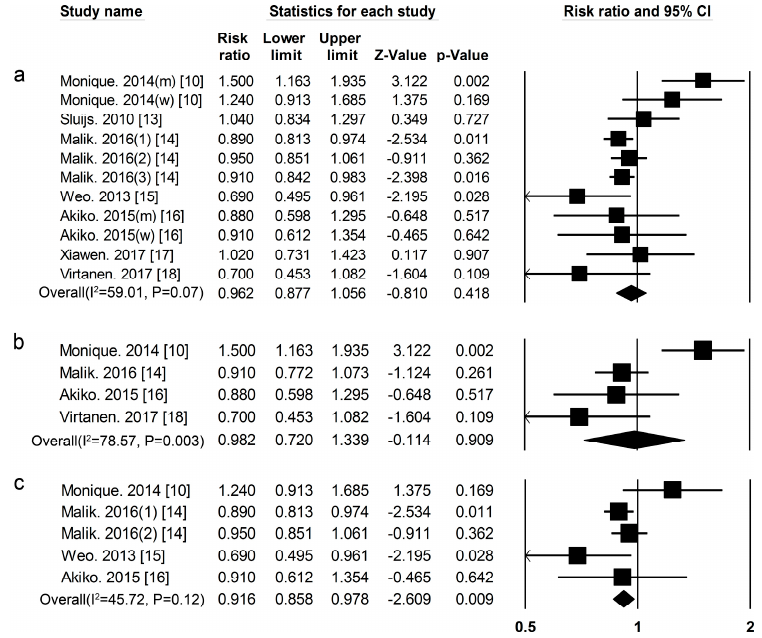
Figure 4. Plant protein and type 2 diabetes RRs for ( a ) the highest vs. the lowest intake in all subjects and ( b ) the highest vs. the lowest intake in men ( c ) the highest vs. the lowest intake in women. The RR of each study is represented by a square, 95% CI are represented by the horizontal lines, and the diamond represents the estimate and its 95%